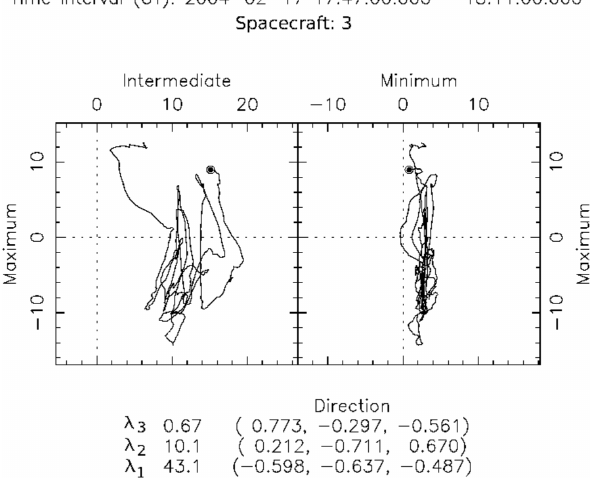
Fig. 4. Magnetic field hodogram obtained by minimum vari- ance analysis applied on Cluster 3 magnetic field data between 17:47:00UT and 18:11:00UT. The left pane represents the projec- tion of the magnetic field in the plane containing the maximum and intermediate variance axis, i.e. in the magnetopause plane. The left panel represents the projection of the magnetic field in the plane containing the minimum and maximum variance axis. The compo- nents in the GSE a plane of respectively the minimum, intermediate and maximum variance axis are given in the bottom of this